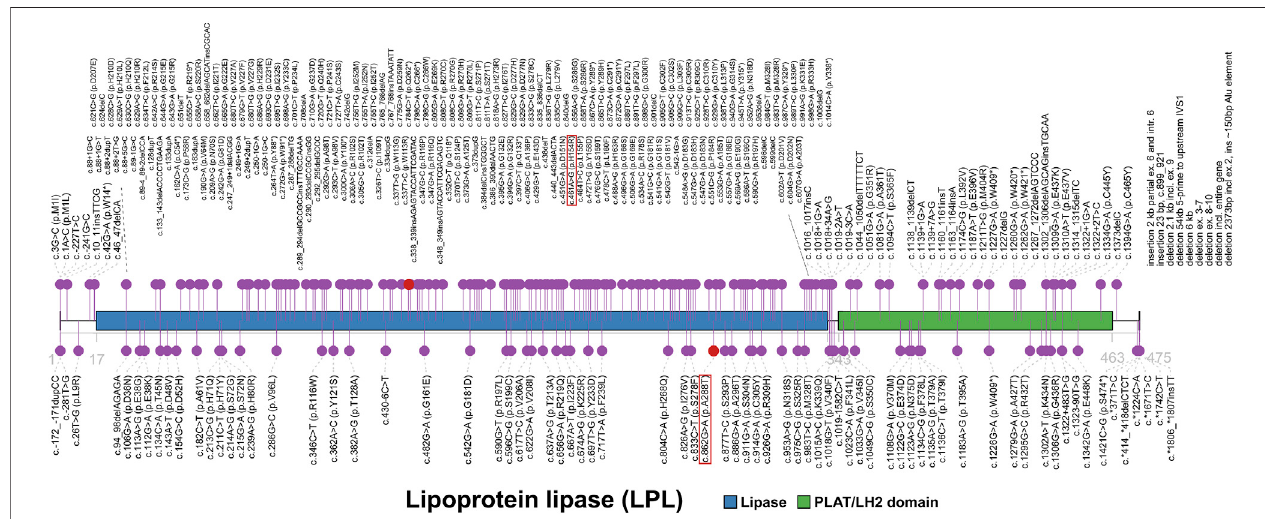
FIGURE3| Thespectrumlandscapeofmutationsin LPL gene.Lipoproteinlipase(1-475)consistsoflipase(17-338)andpolycystin-1,lipoxygenase,alpha-toxinor lipoxygenase homology (PLAT/LH2) domain (343-463). A total of 287 mutations and polymorphisms of LPL gene were reported in HGMD. Disease-causing mutations (DMs) are marked in the top. Other non-DMs and polymorphisms are marked in the bottom. Two variants identi fi ed in our case are highlighted in red square.